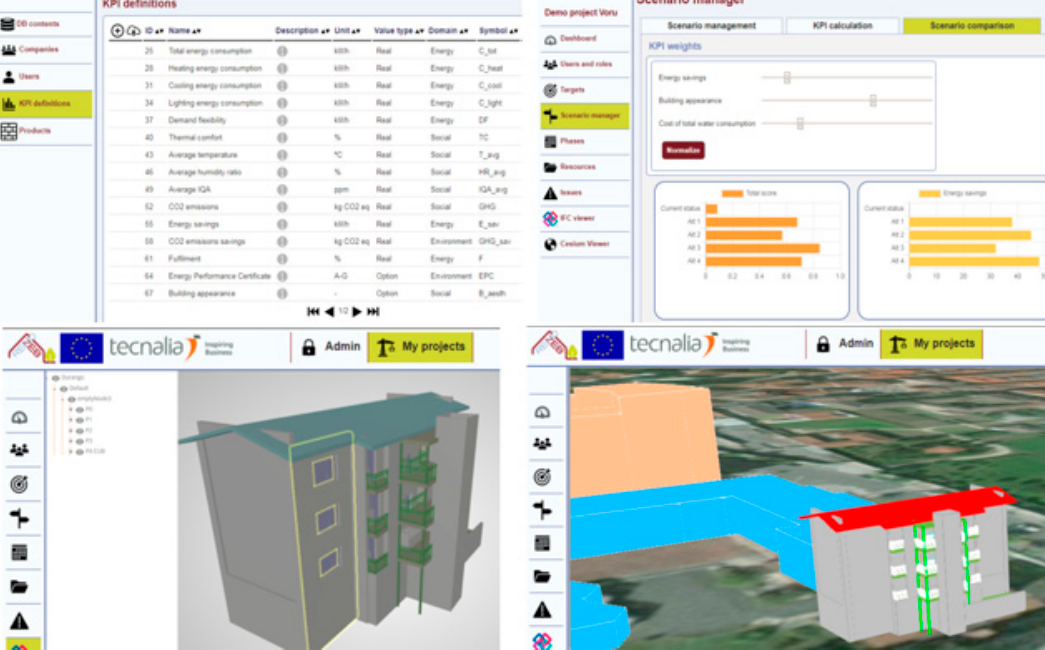
Figure 1. nD Collaborative platform: KPI management & evaluation ( top ) and IFC viewers ( bottom